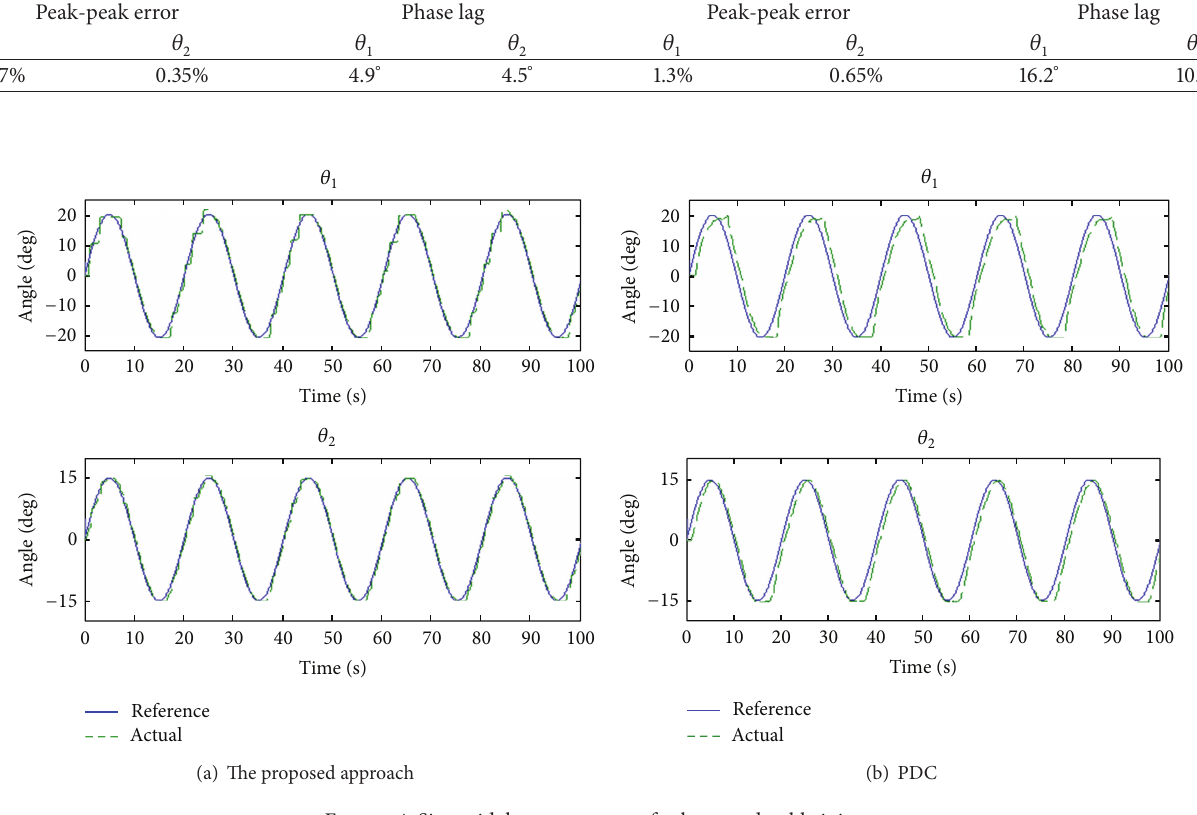
Figure 4: Sinusoidal wave response for knee and ankle